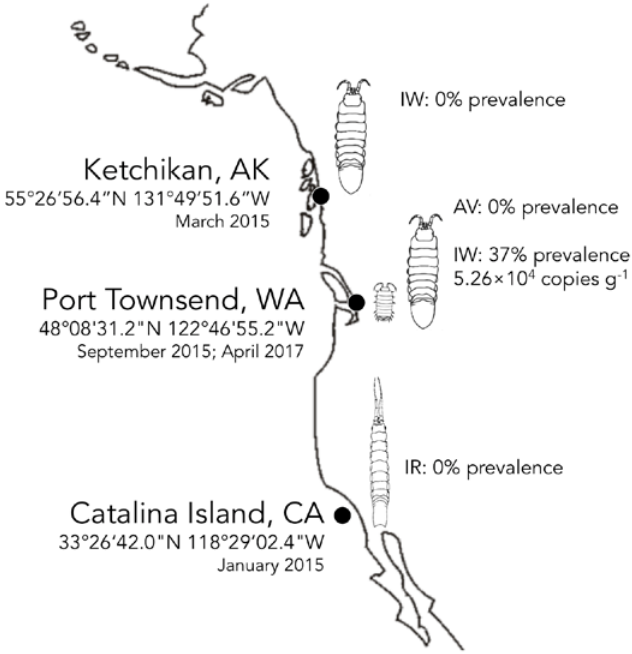
Figure 3. Biogeography of IWaV278 among intertidal isopods on the Pacific Coast of North America. Distribution (prevalence and average load g − 1 ) of genotype IWaV278 was quantified in Idotea wosnesenskii from Washington and Alaska, USA, via qPCR targeting IWaV278- rep . IWaV278 was not detected in taxonomically-related isopods (IR— Idotea resecata ) from the Channel Islands (USC Wrigley Institute, CA, USA), sympatric isopods (GO— Gnorimosphaeroma oregonensis ) or primary dietary substrate ( Nereocystis sp ).